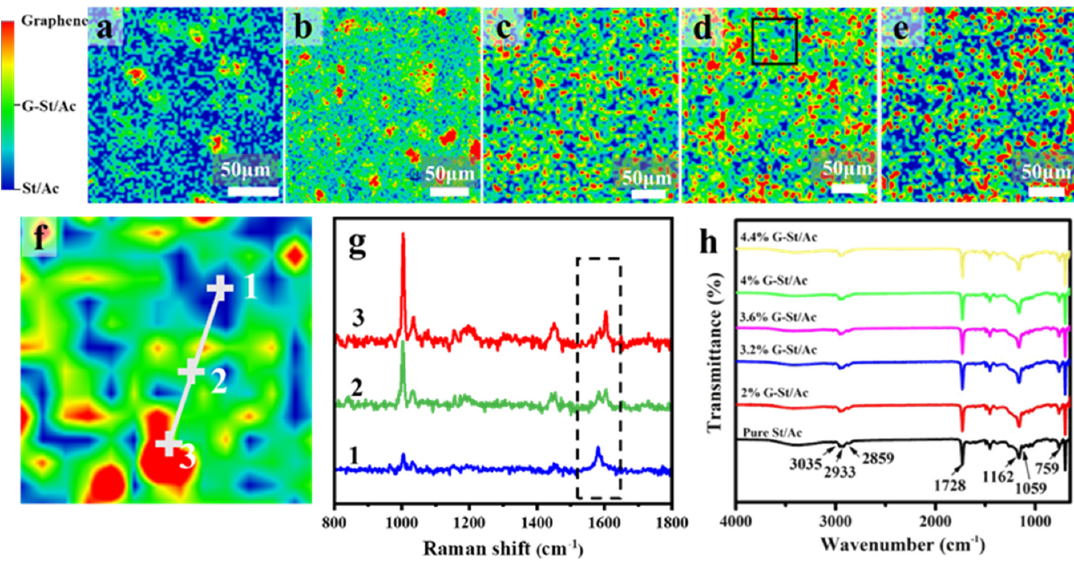
Figure 3. ( a – e ) Raman mapping of the graphene-modified styrene–acrylic emulsion with 2.0, 3.2, 3.6, 4.0 and 4.4 wt% addition of the aqueous graphene dispersion. ( f ) The enlarged view of the selected part of ( d ). ( g ) The Raman spectrums of the three representative sites in ( f ). ( h ) The FT-IR spectrums of the graphene-modified styrene–acrylic emulsions with different amounts of graphene dispersion